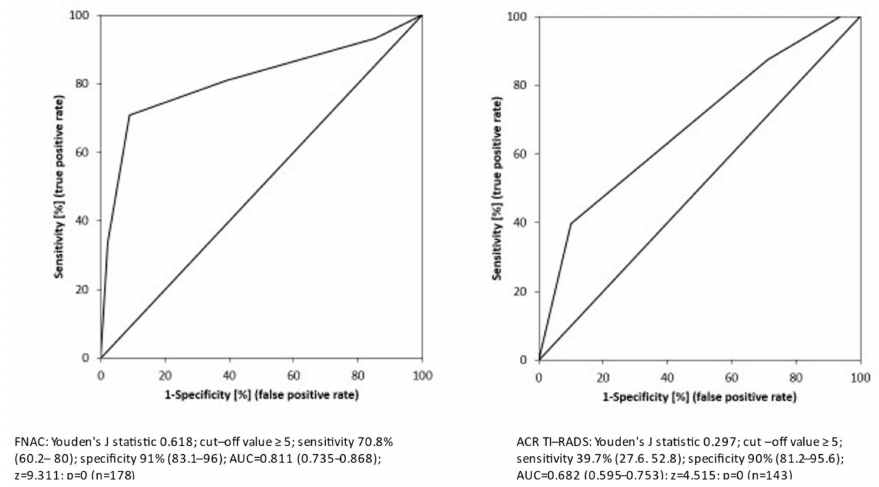
Figure 4. ROC analysis of FNAC and ACR TI-RADS, cut-off values ≥ 5 both FNAC (Bethesda category V–VI) and ACR TI-RADS (TR5).